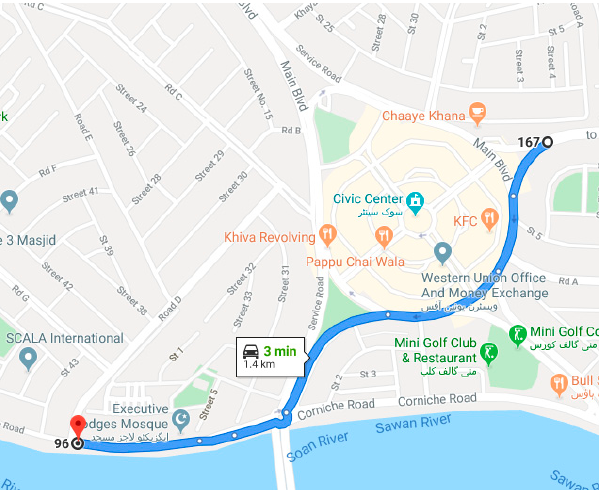
Figure 18. Test Track Map (Zoom Scale 500 ft.).